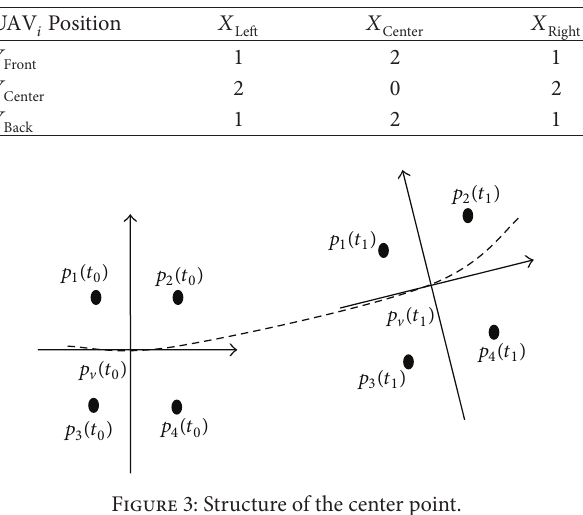
Table 1: Formation example form.